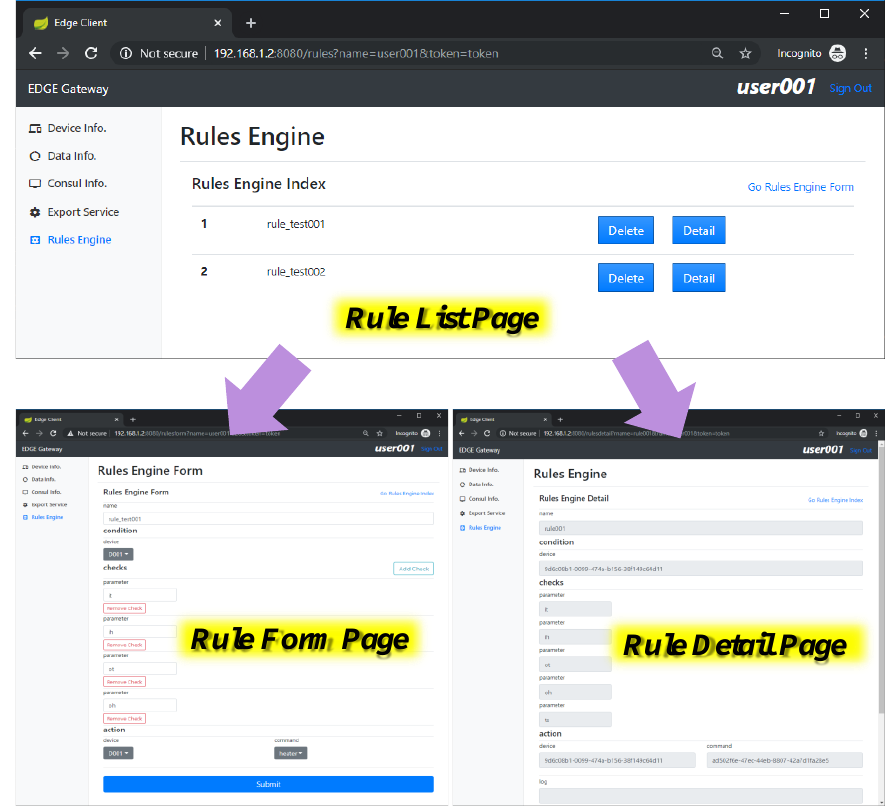
Figure 14. Rules management using edge client.